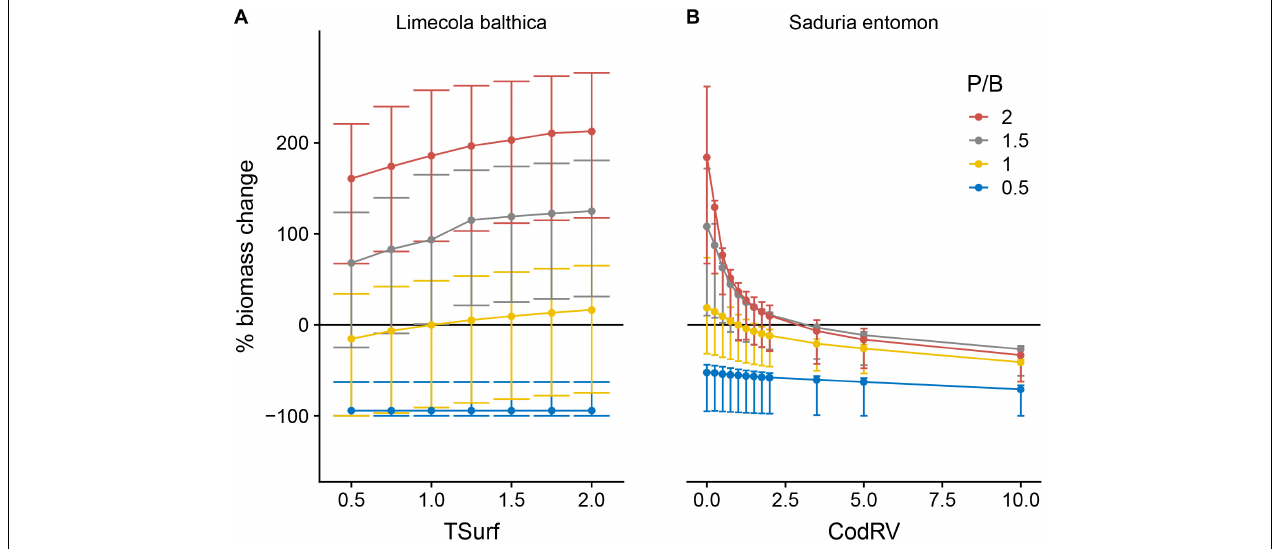
FIGURE 4 | Change in biomass of L. balthica as a function of relative changes in TSurf (A) and S. entomon as a function of relative changes in CodRV (B) at four different levels of P/B, where 1 denotes baseline forcing. Biomass change is relative to baseline equilibrium value. Error bars show the variability in biomass change due to varying OxAr and CodRV (A) and OxAr and TSurf (B) . Horizontal line indicates no change. Results from simulations with CodRV = 0, resulting in 0 cod biomass, are excluded from the figure. Forcing abbreviations are explained in Table 1